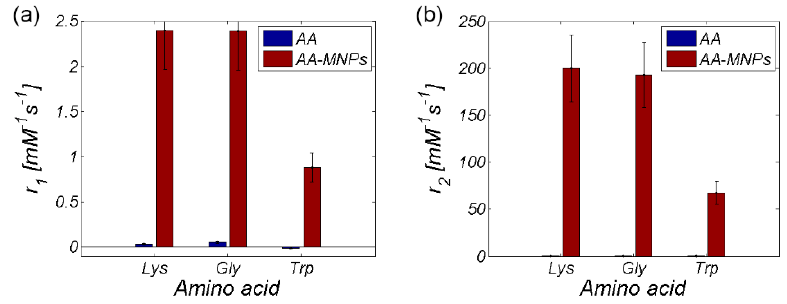
Figure 13. Relaxivity comparison of MNP complexes with and without AA coating ( a ) r 1 and ( b ) r 2 .